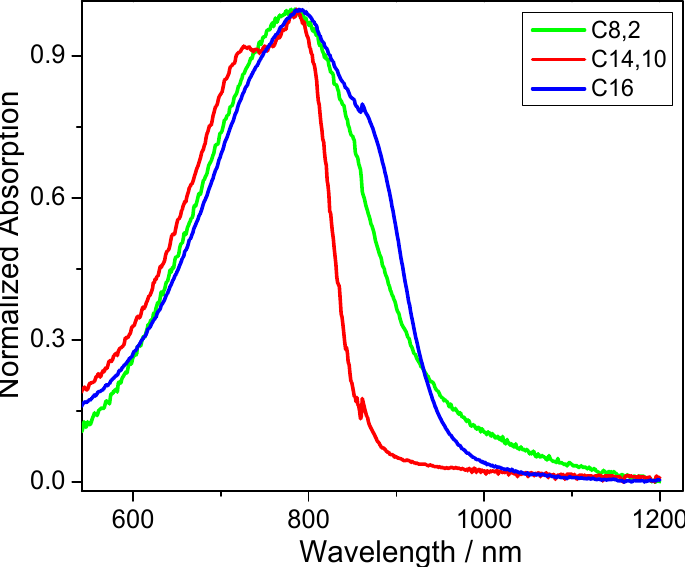
Figure 2. UV-Vis absorption spectra for thin films of CDT-BTZ polymers with different side